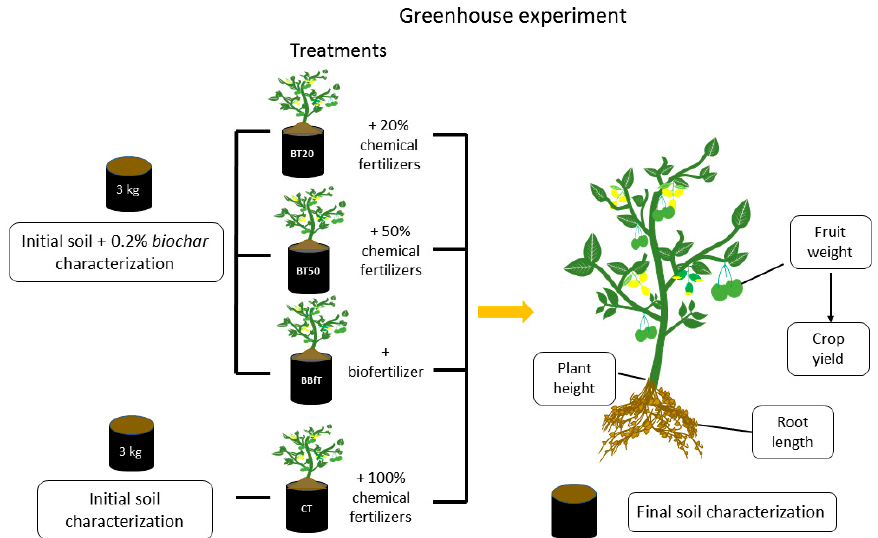
Figure 1. Experimental design for the greenhouse study. BT20 and BT50: soil + biochar + 20% or 50% of chemical fertiliza- tion, BBfT: soil + biochar + biofertilization, CT: soil + 100% chemical